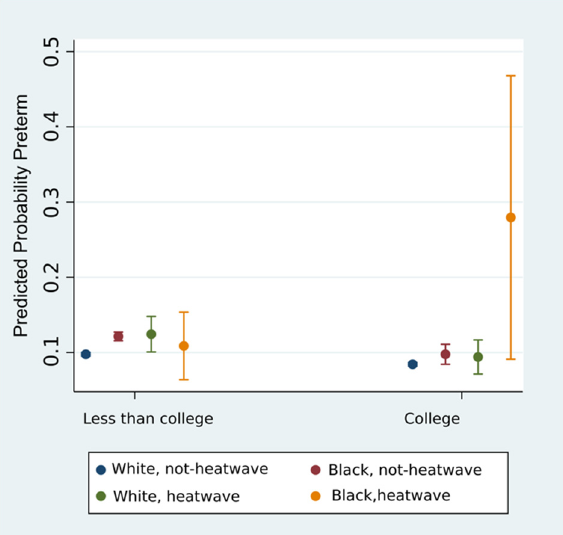
Figure 1. Probability of PTB for White and Black mothers, across strata of education, and exposure to heat waves.